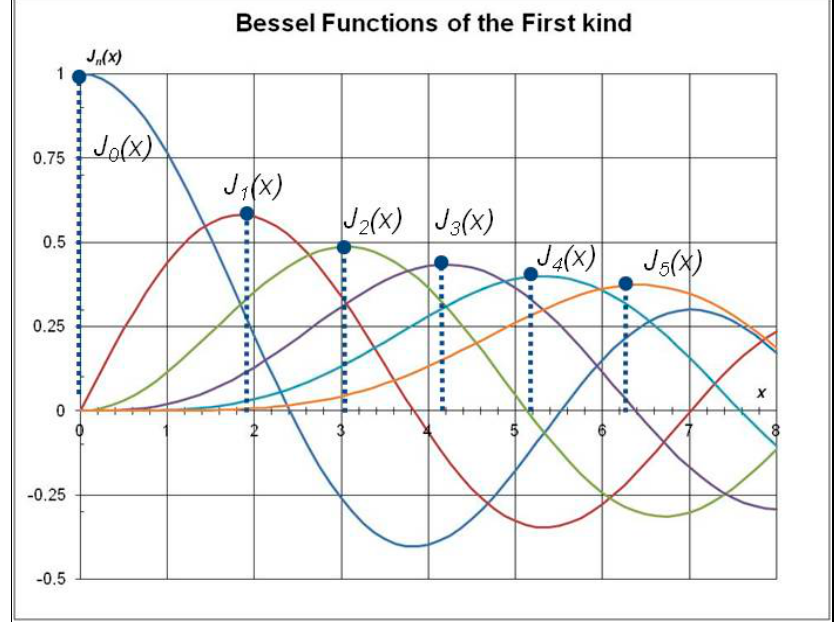
Figure A3. Plots of the first few orders of Bessel functions of the first kind.